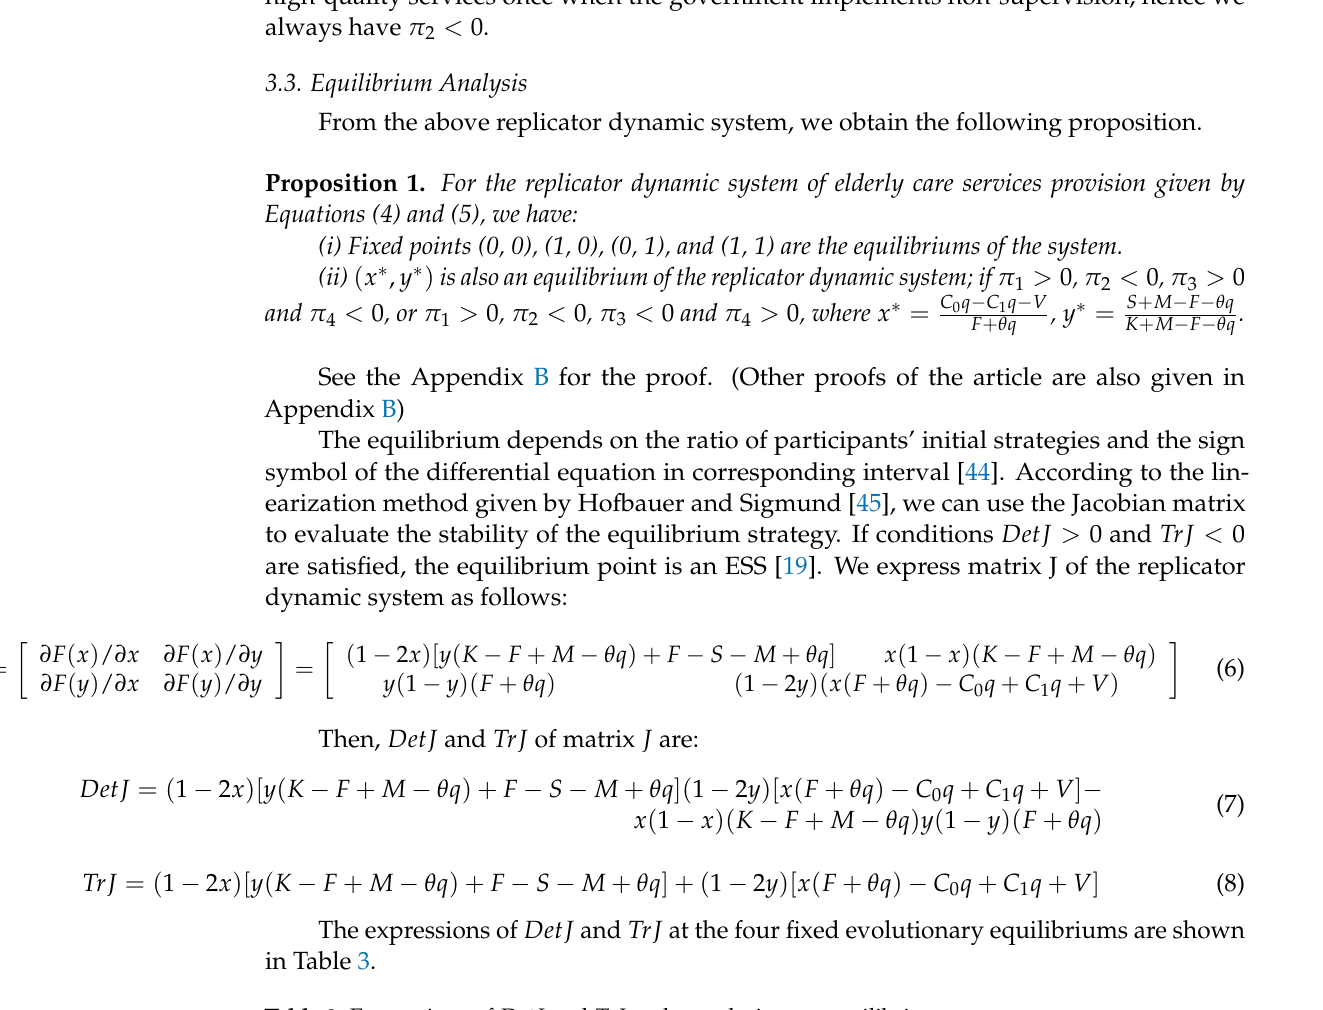
Table 3. Expressions of DetJ and TrJ at the evolutionary